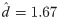
Shuffling behavior inside the flock.(A) Mean square displacement in the center of mass reference frame up to 30 steps. D = 26.0 and α = 1.59. (B) Neighbors overlap. QM against time t for groups of 100 individuals. Full lines represent Eq (6) for 0.66 (fitted value) with αm = 1.55 and d^=1.67. (C) Neighbors overlap: QM against number of neighbors M for 100 individuals. Values are not fitted for high M because M is too large for the group size (M = 80 and N = 100).